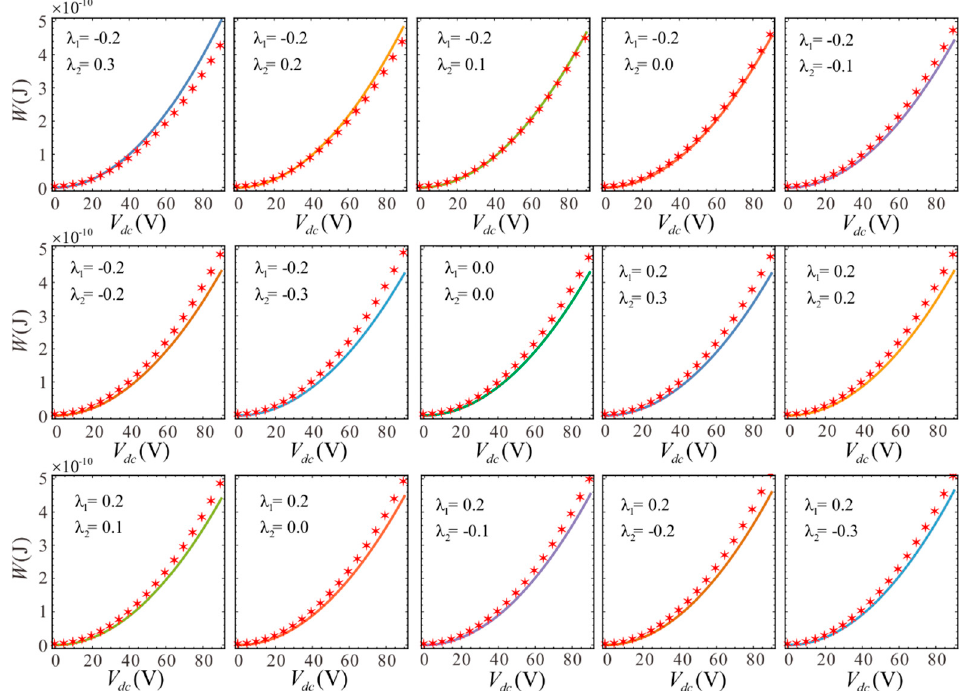
Figure 4. The relationship between the DC voltage and potential energy for different values of section parameters. Lines show the analytical solutions and symbols show the finite element solutions.